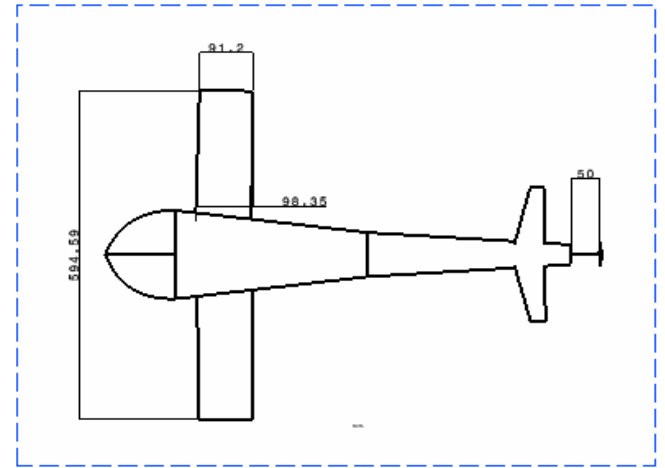
Figure 31. Design of optimised UAV—A typical view—1.